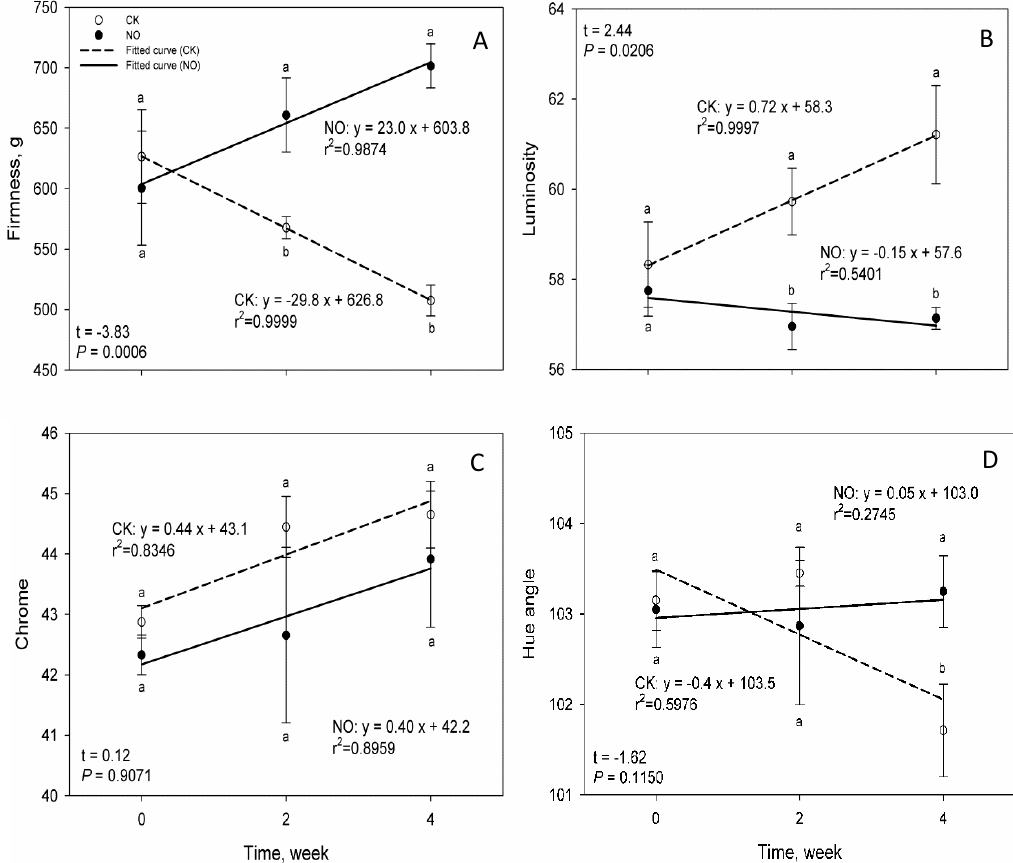
Figure 1. Correlations of firmness, luminosity, chroma, and hue angle of apples from the nitric oxide fumigation (NO) and the control (CK) with post-treatment storage time at 2 °C and comparisons between the fumigation treatment and the control. The four graphs represented the four parameters and were denoted as A , B , C , and D respectively. For each parameter, the two values for the treatment and the control at a same time followed by different letters were significantly different at P ≤ 0.05 based on t -test [13]. The statistical values of t and P for each parameter were for comparison of slopes of the regression lines for the treatment and the control.